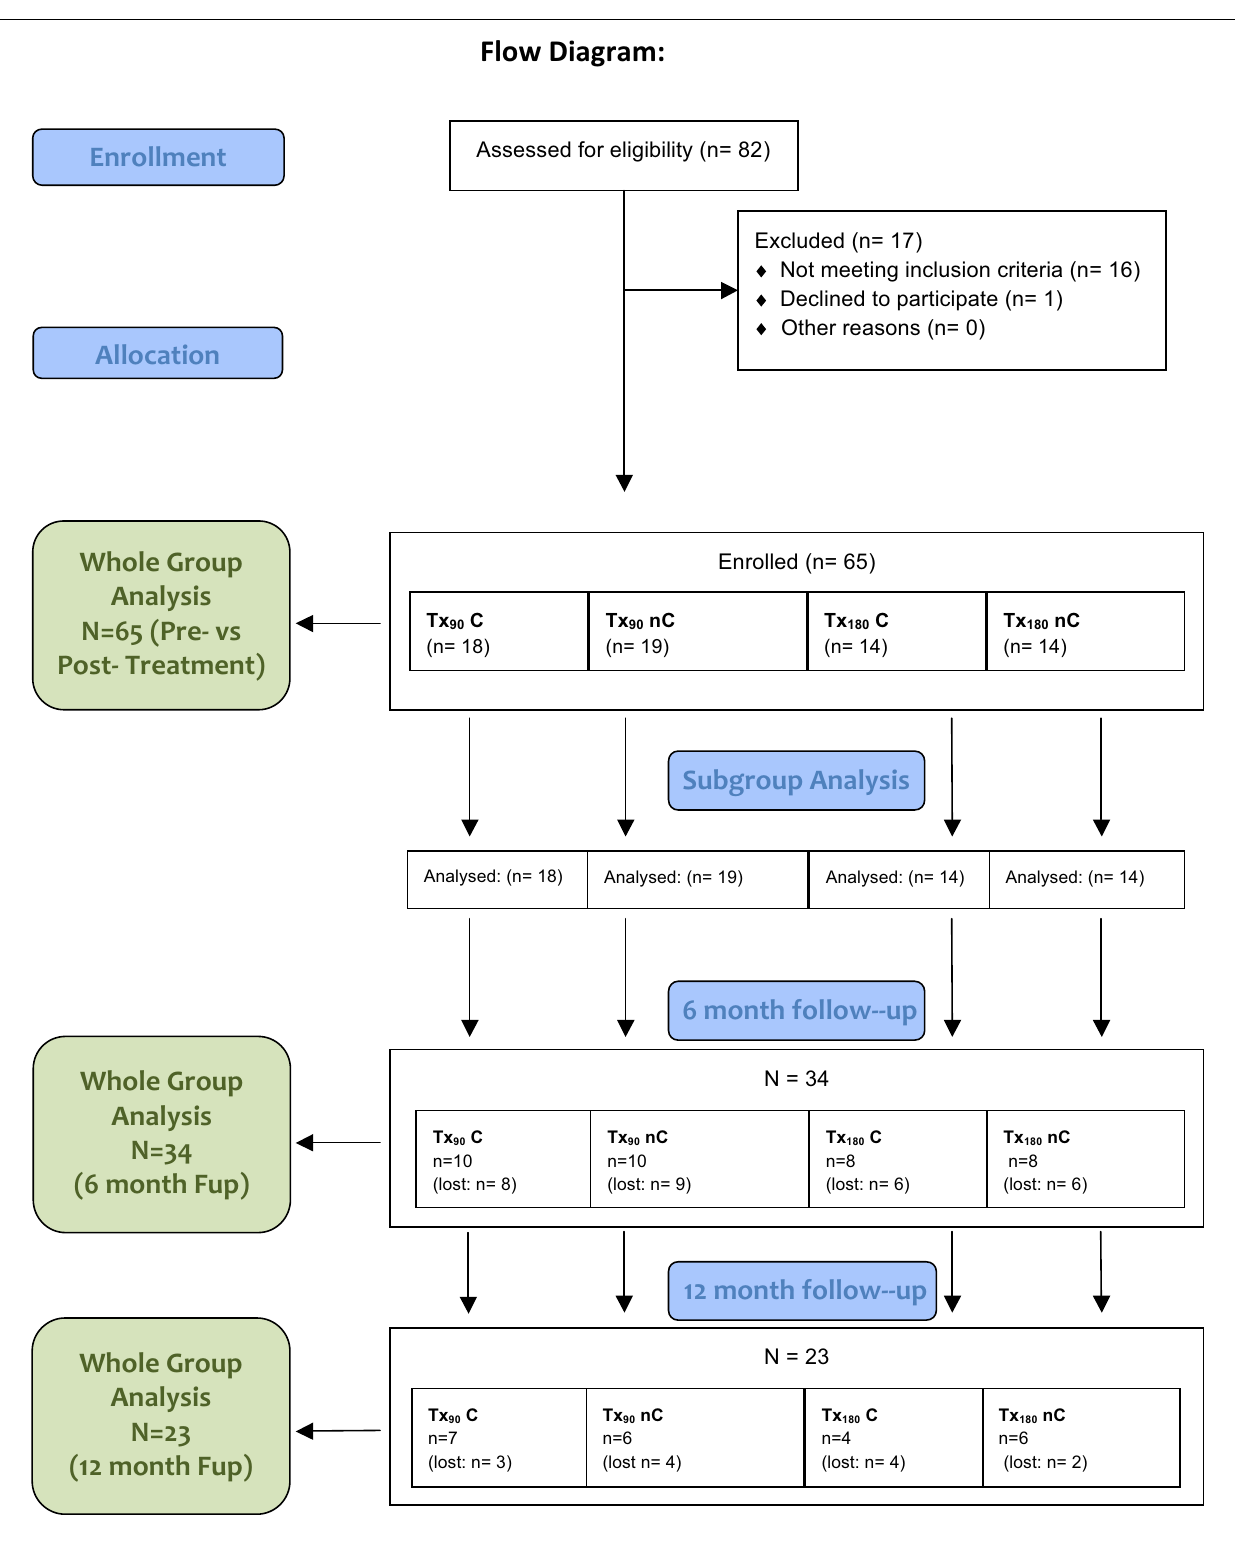
a full breakdown of n per test is given in the supplementary materials, and (4) the cause for drop out were difficulties/unwillingness to traveling to the University (many patients had come from further